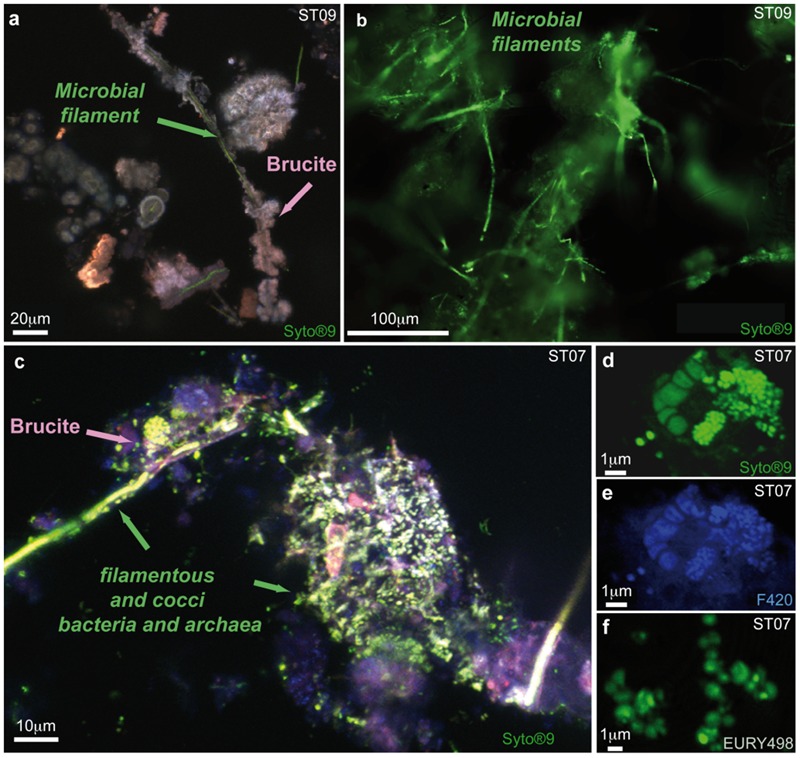
Epifluorescent image and maximum intensity projection of stacked Confocal Laser Scanning Microscopy (CLSM) images highlighting a different microbial diversity between young ST09 chimney and mature ST07 chimney. (a) Maximum intensity projection of stacked CLSM images illustrating the quasi exclusive presence of Syto®9-stained biofilaments (green) being mineralized by brucite (in pink) in juvenile chimney conduits sampled at site ST09, without any archaeal cell around (no F420 autofluorescence); (b) Detail of the filament-rich areas observed by epifluorescence after Syto®9-staining that were dissected for 16S rRNA gene analysis; (c) Composite image showing the presence with respect to brucite mineralization of diverse microorganisms and notably of archaeal cocci (Syto®9 fluorescence superimposed with F420 autofluorescence) and filaments in ST07 mature chimney; (d) Clusters of Syto®9-stained cells showing cocci of less than 1 μm in size; they were identified as methane-cycling archaea thanks to the autofluorescence of the F420 factor implied in their metabolism (e) and to the positive fluorescence after hybridization with the FITC-labeled probe specific for Euryarchaeota EURY498 (f).